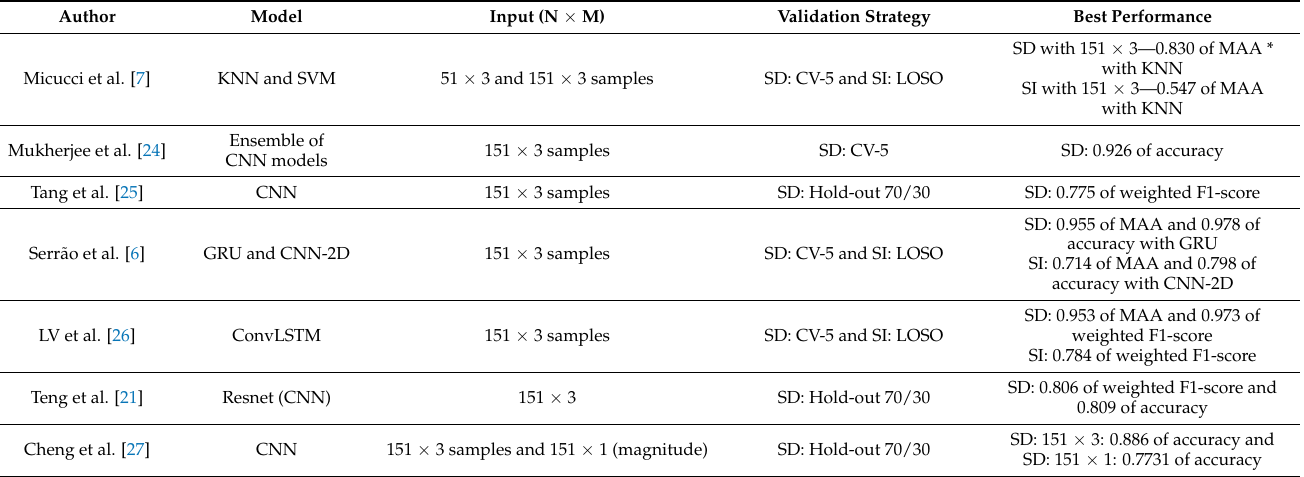
Table 2. State-of-art studies using the UniMiB-SHAR dataset; N × M—N is the input size and M is the input dimension; SD—subject-dependent; SI—subject-independent; CV—cross-validation;